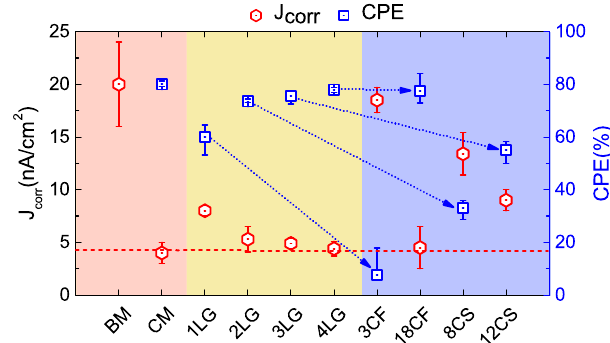
Fig. 8 Corrosion measurements. Corrosion current density J corr and corrosion protection ef fi ciency (CPE) for different samples. The corrosion resistance varies inversely with J corr 51 . 2 – 4LG have similar CPE to~2.7nm CMC and~1.8nm COC in sample 18CF. The dotted line is a guide to the eye for J corr of different samples. The arrow compares various 1 – 4LG-COCs pairs, such as 1LG → 3CF, 2LG → 8CS, 3LG → 12CS, and 4LG → 18CF, as the 1 – 4LG- based sample in each pair is always slightly thinner than the amorphous COC. The red shaded region highlights the bare media and media with a commercial overcoat, the yellow region highlights media with graphene overcoats and the blue region highlights media with FCVA-deposited ta-C. The horizontal red dashed line is a reference at J corr = 4nA/cm 2 . The error bars stem from taking the average of multiple repeated measurements.